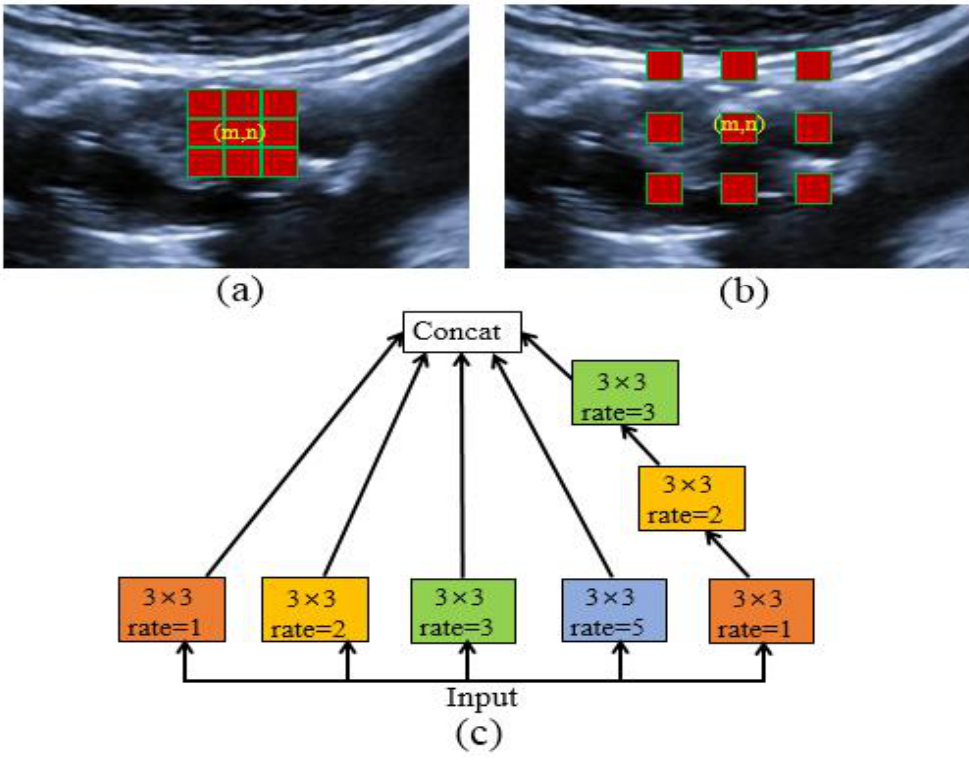
Figure 6. Schematic diagram of atrous convolutions. A pixel point (m, n) in a convolution with kernel 3 × 3, atrous rate r = 1 ( a ) or r = 2 ( b ). ( c ) Hybrid atrous convolutions (HACs) module with convolution 3 × 3; atrous rate 1, 2, 3, and 5; and a cascaded atrous rate 1, 2, and 3.